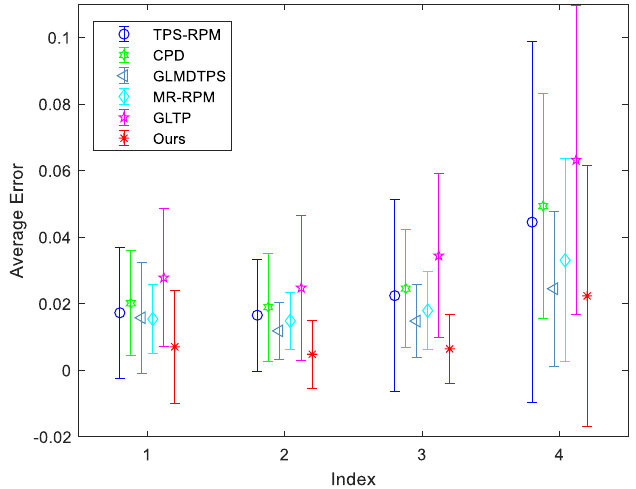
Figure 8. Quantitative comparisons of TPS-RPM, CPD, GLMDTPS, MR-RPM, and GLTP, and the proposed method on IMM hands dataset. From index 1 to 4, they represent the registration results from Group 1 to Group 4, respectively. The error bars indicate the mean and standard deviation of registration errors over 90 trials.